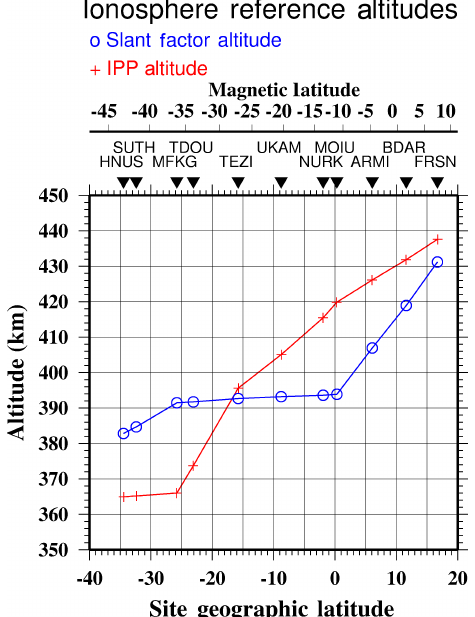
Figure 2. Ionosphere reference altitudes, used for the determination of the ionospheric penetration point (IPP) and the slant-to-vertical conversion for TEC, for each of the stations in the